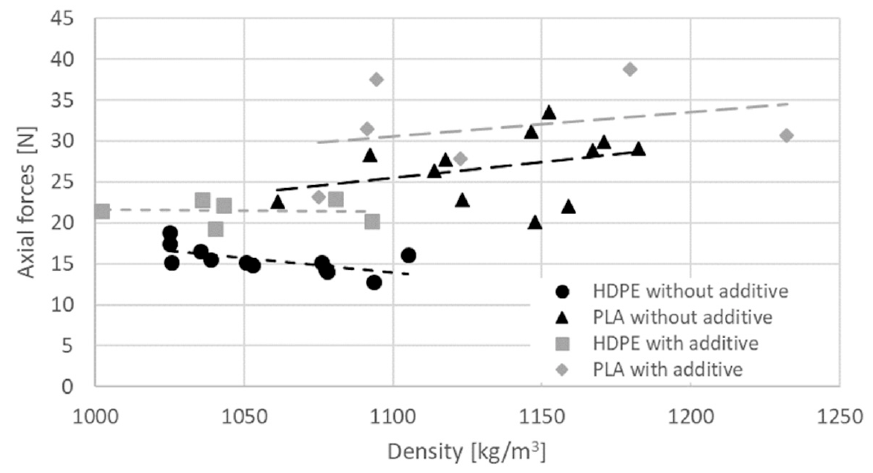
Figure 3. Relationship between axial forces during drilling and the density of WPCs.